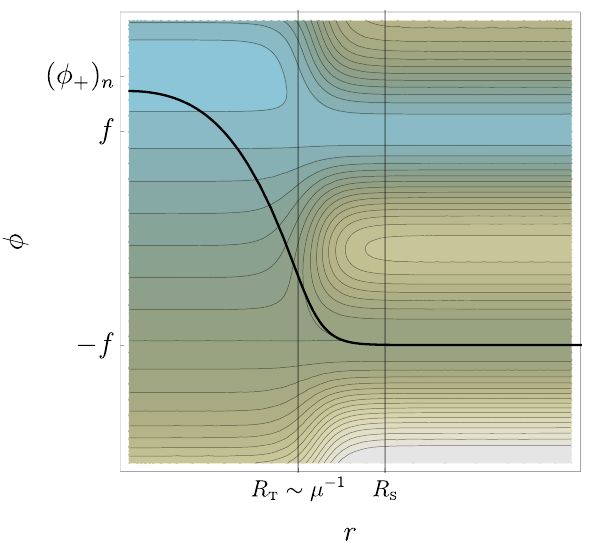
≳ 1 on top of contours of the scalar T